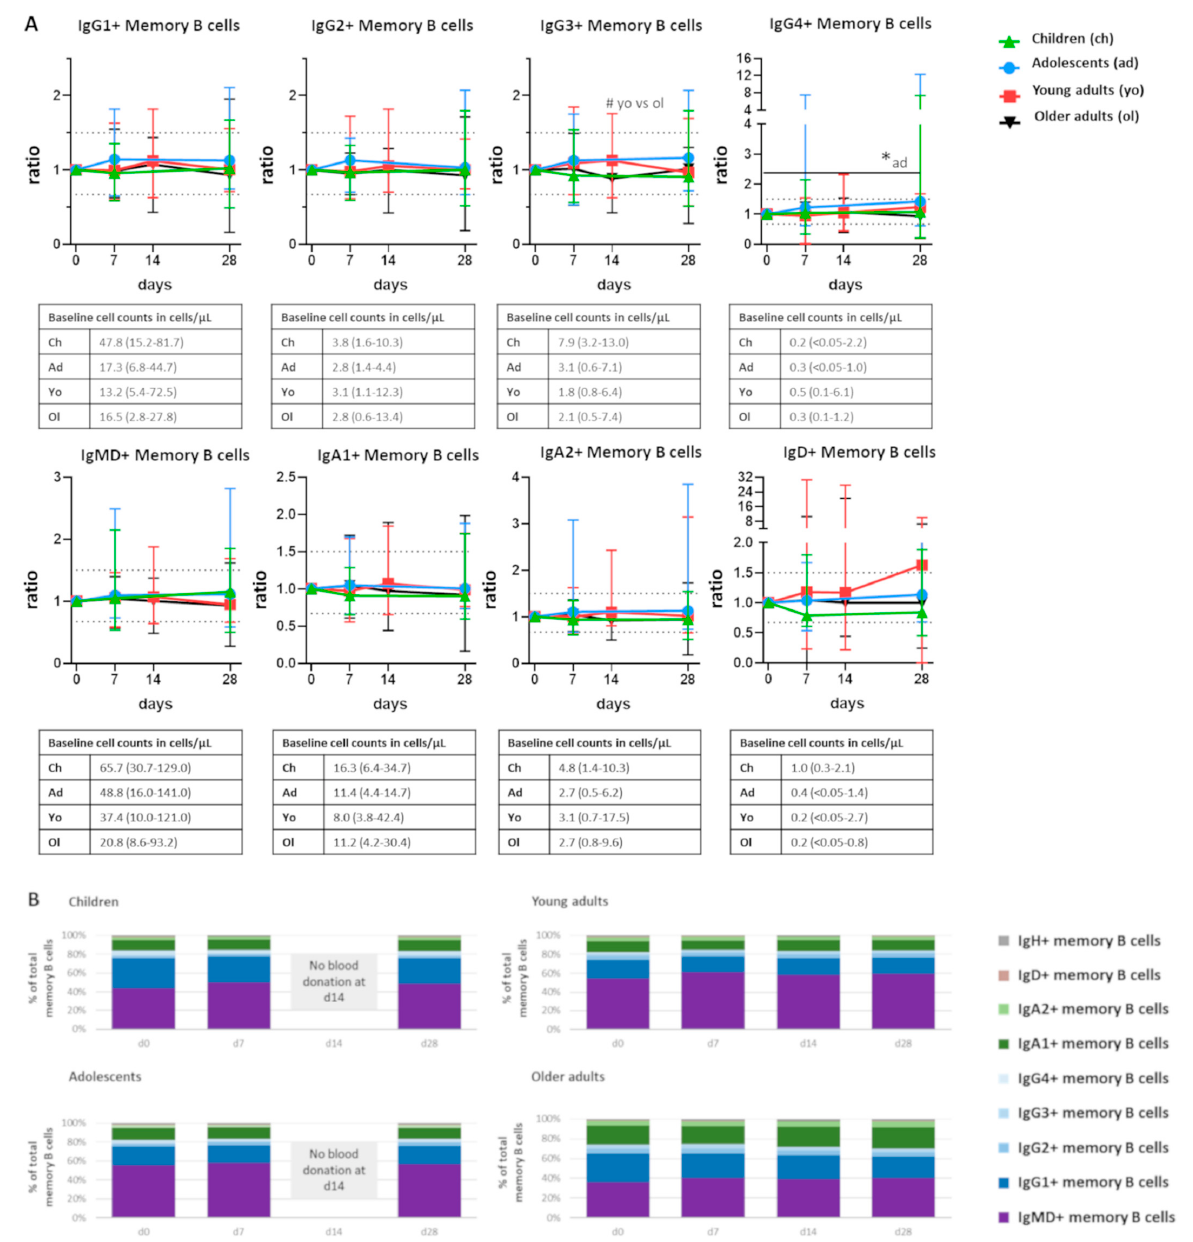
Figure 4. Stable distribution of memory B-cell subsets over time after vaccination. ( A ) Quantitative changes in memory B cells expressing different Ig subclasses, presented as ratio over baseline (median, min-max). Dashed lines indicate a ratio over baseline of 0.67 and 1.5. Underneath each graph, a table shows the baseline cell counts of that population in cells/ µ L (median, min-max). ( B ) Over-time distribution of memory B cells expressing different Ig subclasses within the total memory B-cell compartment. Median values for each population were used to construct the plots. Wilcoxon matched pair signed-rank test followed by Bonferroni correction was used to assess longitudinal differences within each cohort. Differences between cohorts were assessed using Kruskal–Wallis followed by Dunn’s test but did not yield significant differences. For pediatric cohorts, no blood samples were collected at day 14; the Mann–Whitney test followed by Bonferroni correction was used. For longitudinal changes, only significant differences compared with baseline are shown as *, p < 0.05. Significant differences between cohorts at the same time point are indicated as #, p < 0.05. d = days after